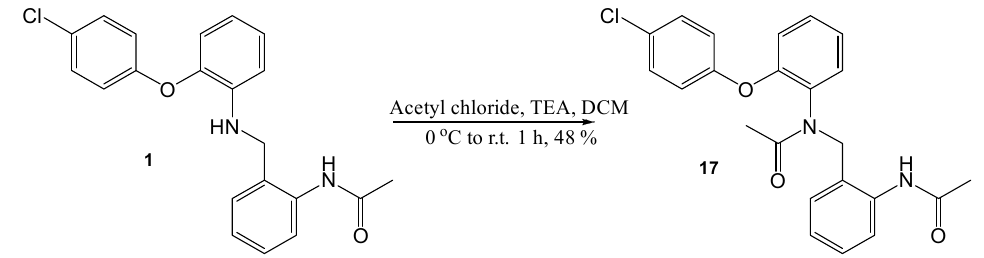
Scheme 9. Synthesis of compound 17 with acetyl groups on the side chain and linker